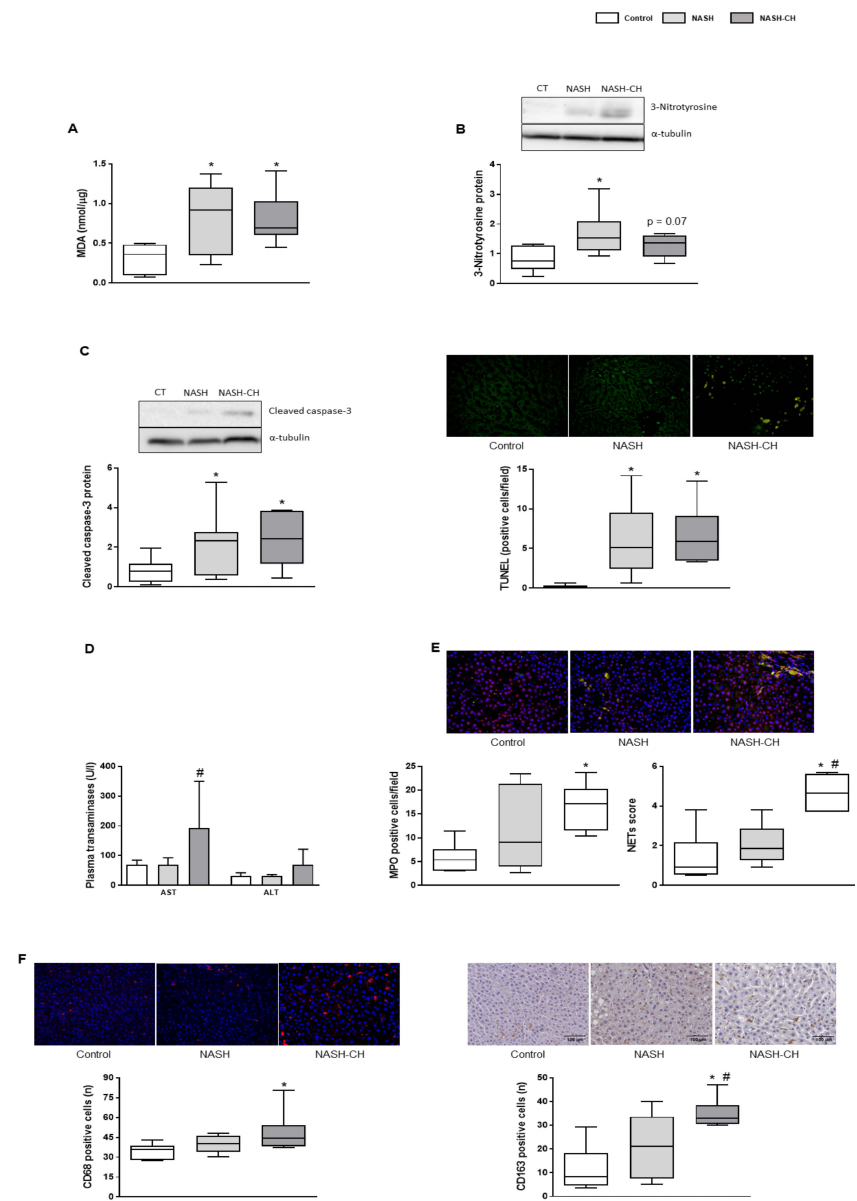
Figure 3. Oxidative stress, cell death, and inflammatory markers in control and NASH animals. ( A ) MDA levels in liver tissue. ( B ) Representative western blot of 3-nitrotyrosine proteins normalized to α -tubulin and quantification. ( C ) Left , representative western blot of cleaved caspase-3 protein normalized to α -tubulin and quantification. Right , representative images of TUNEL staining in liver tissue and quantification. ( D ) Plasma transaminases (AST and ALT). ( E ) Representative images of neutrophil immunofluorescence in liver tissue (MPO in green, histone 2B in red, nuclei in blue). Left, neutrophil infiltration measured as MPO positive cells. Right, analysis of hepatic neutrophil extracellular traps (NETs) determined as co-localization of MPO and histone 2B. ( F ) Left , representative images of CD68 immunofluorescence in liver tissue and quantification. Right , representative images of CD163 immunohistochemistry in liver tissue and its quantification. Results represent mean ± SEM, * p < 0.05 vs. control group, # p < 0.05 vs. NASH group ( n = 6 rats per group). All images scale bar = 100 µ m. Hepatic cell death evaluation revealed significant increases in cleaved caspase-3 protein expression and TUNEL quantification in both groups of BarNa rats (Figure 3C), accompanied with elevated plasma transaminases in the NASH-CH group (Figure